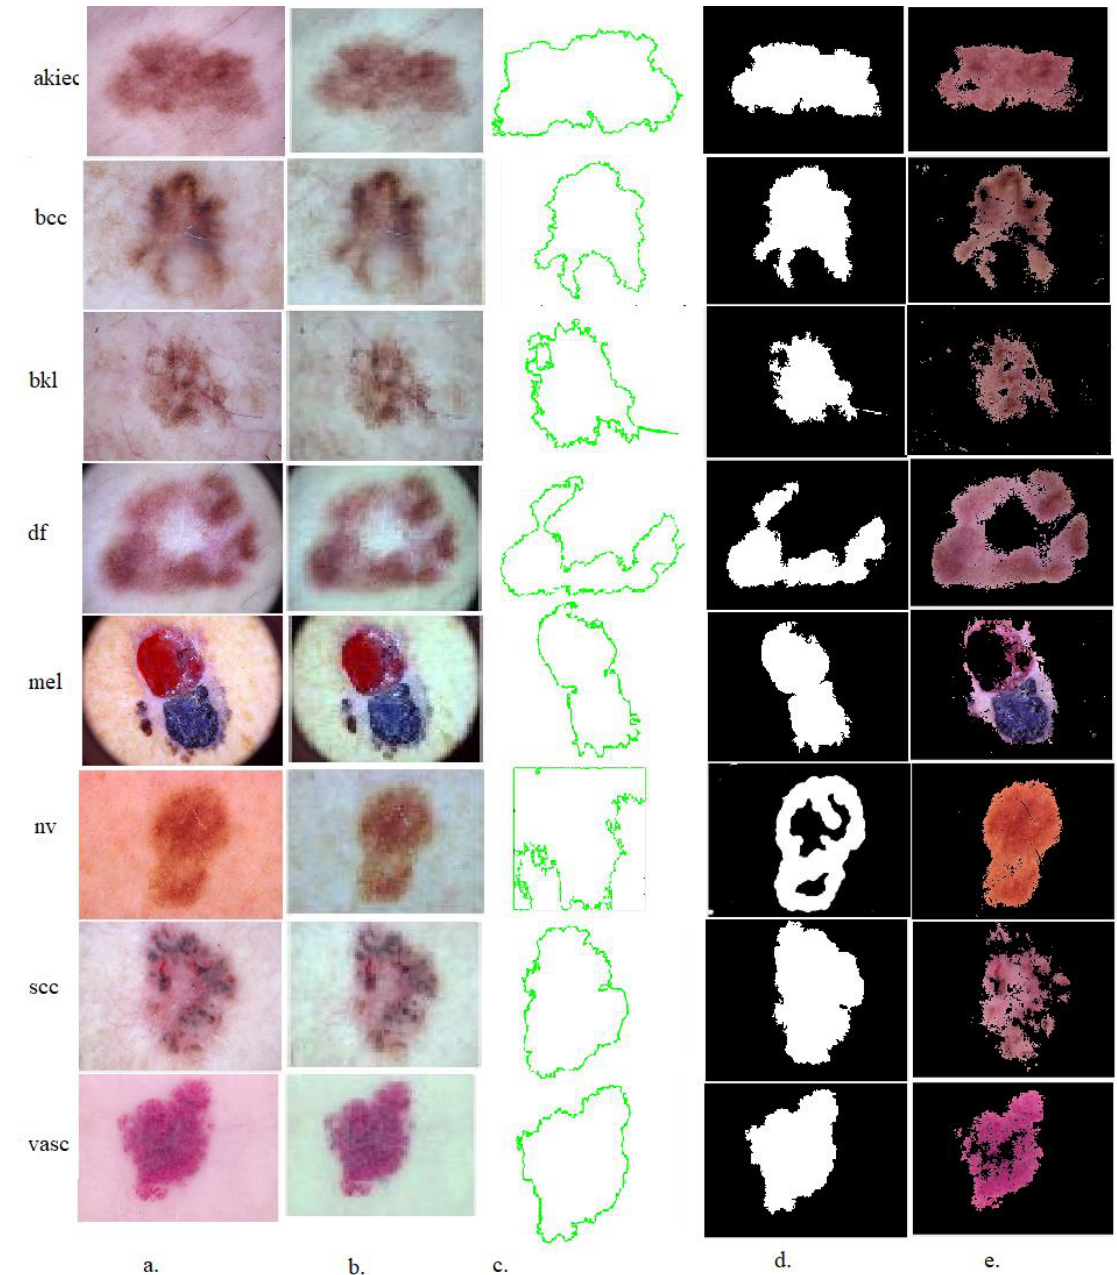
Figure 2. A sample from each class of the ISIC 2019 dataset for extracting the lesion area and its isolation from the healthy skin using the GAC method ( a ) Original images ( b ) Enhanced images ( c ) Selection of the lesion area ( d ) Segmentation of the lesion area ( e ) Lesion area (ROI).